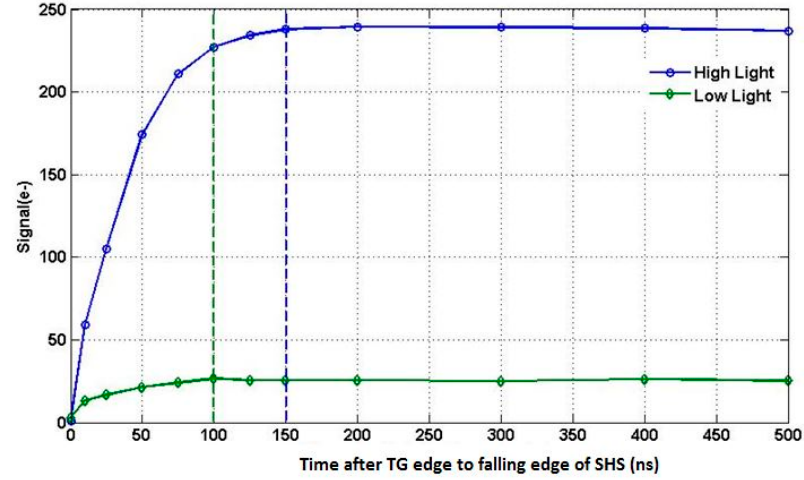
Figure 9. ADC output signal vs. time from edge of TG to falling edge of SHS.